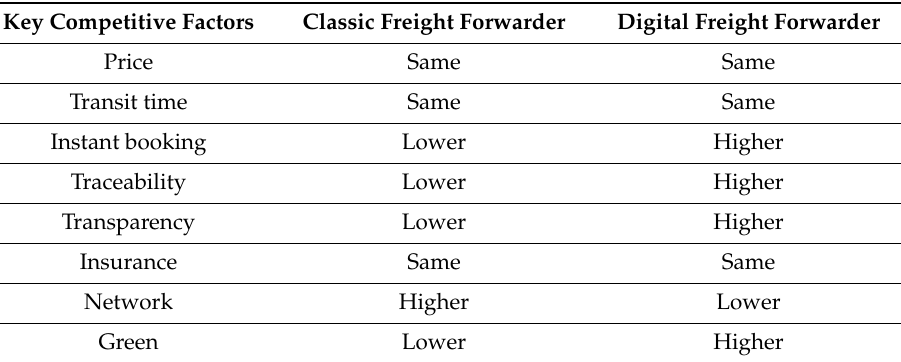
Table 5. Competitive advantage of digital vs. classic freight forwarders. Key Competitive